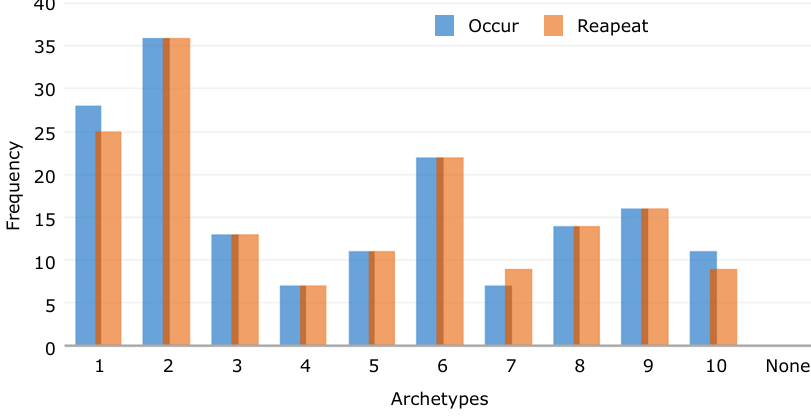
Fig. 3. Occurrence of system archetypes at